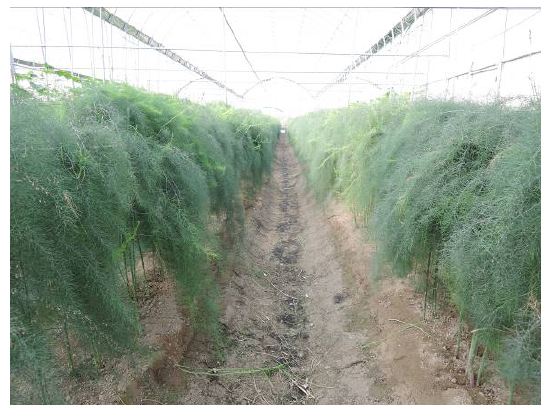
Figure 8. An asparagus greenhouse